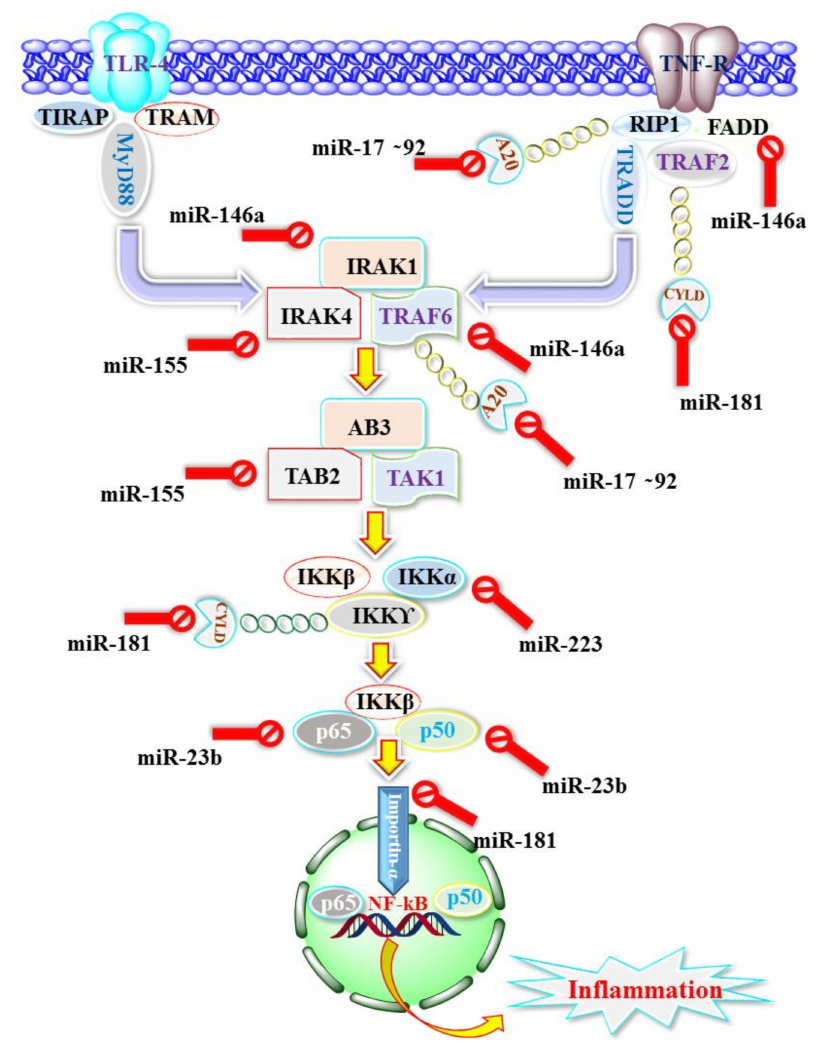
Figure 1. Showing the involvement of miRNAs as the central regulator of immunity via NF-kB pathway. TIRAP, TRAM, TLR4, TNF-R, RIP1, FADD, TRAF-2, TRADD, IRAK, TAB-2, TGF- β - activated kinase 1/MAP3K7-binding protein 2; TAK, IKK, and